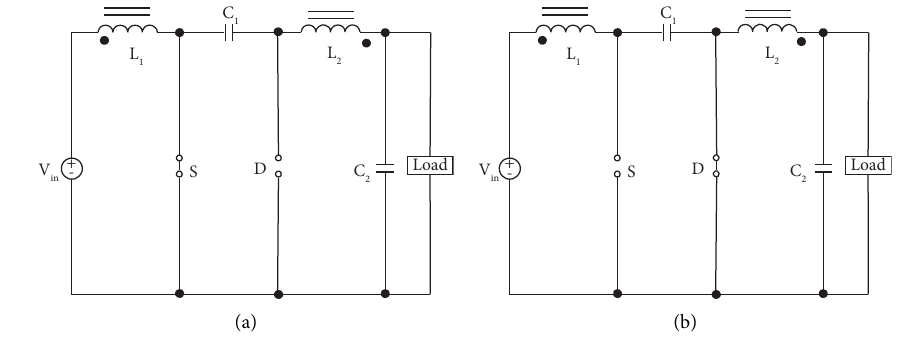
Figure 2: Switch on and of circuits of the Cuk converter.